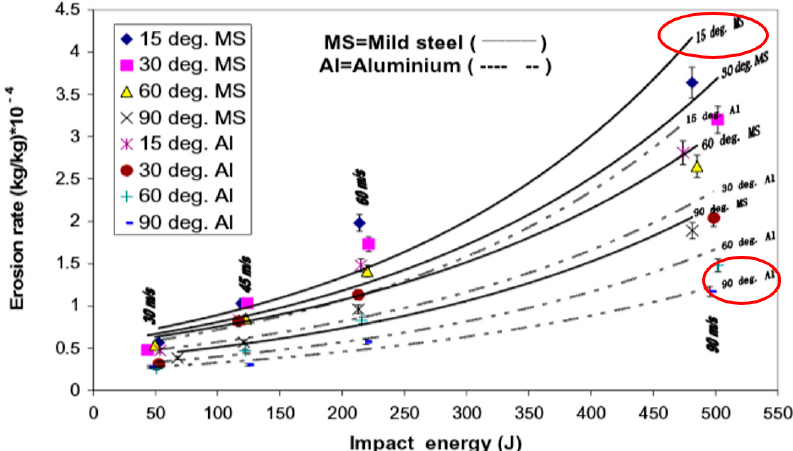
Figure 7. Erosion rate dependency on particle impact energy and angle for mild steel and aluminium. Reproduced with permission from [54]. Elsevier, 2014.